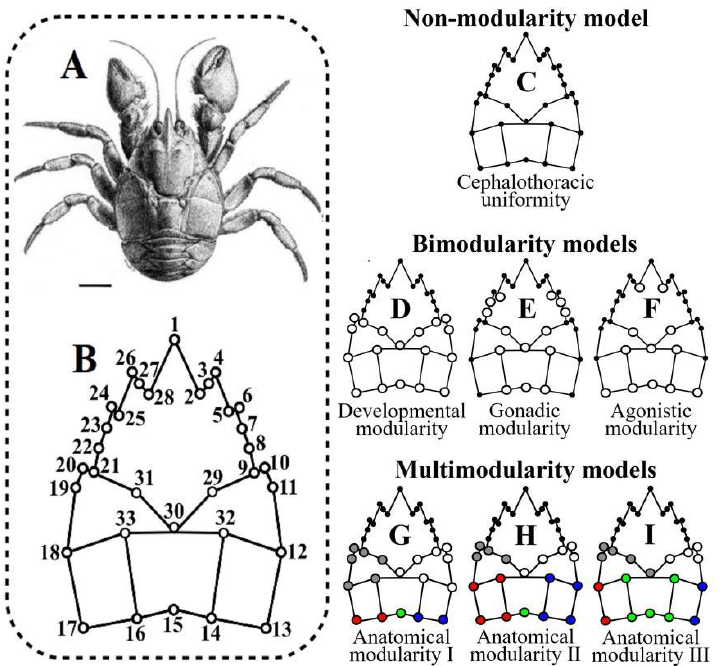
Figure 2. Morphological analysis applied to the dorsal cephalothoracic surface of Aegla araucaniensis. ( A ) Paratype of A. araucaniensis (bar = 5 mm). ( B ) Configuration of landmarks used in this study